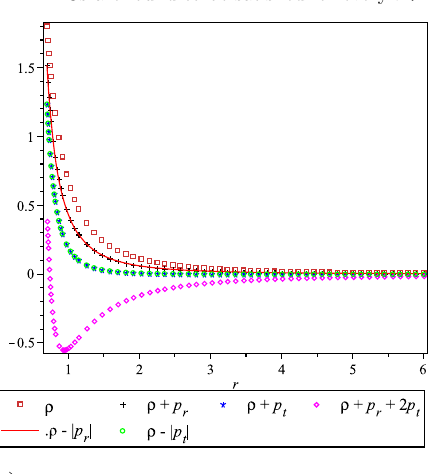
(c) This figure depicts the behavior of all EC terms for Model-II in Subcase 7 ( ξ 2 > 0, α 2 < 0, α > 0). All ECs are found to be satisfied for every r > 6.